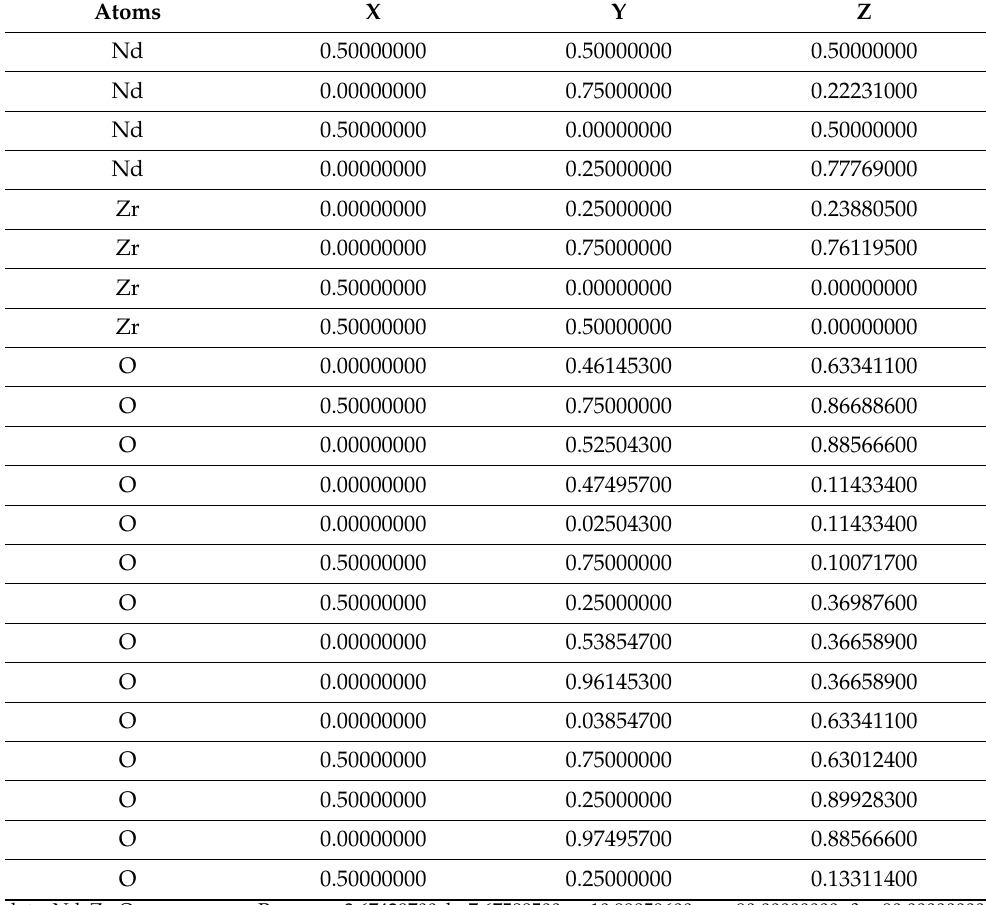
Table 2. Space group Pmma, lattice parameters, and fractional